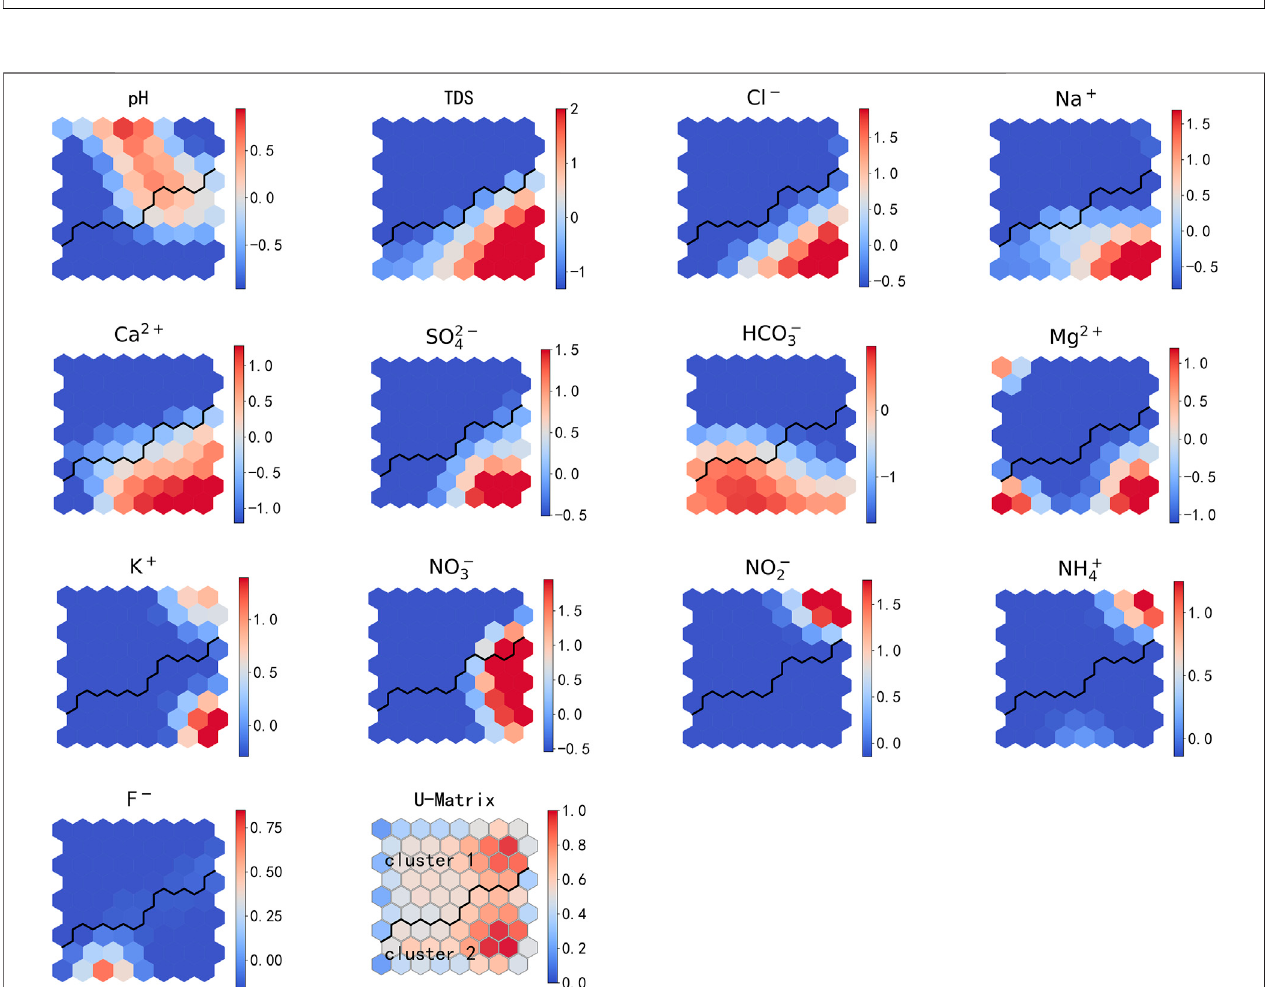
Frontiers in Environmental Science |